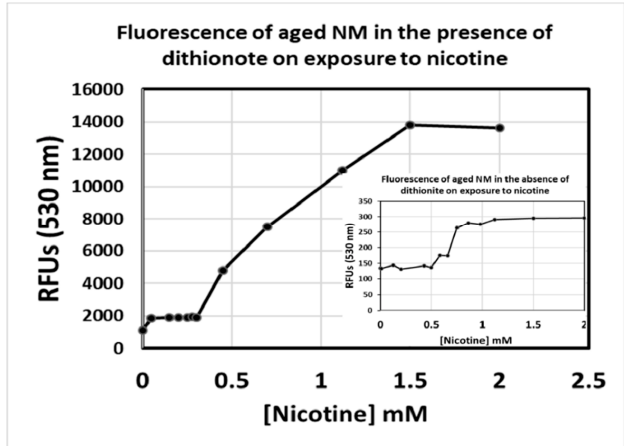
Figure 4. Fluorescence of synthetic neuromelanin upon exposure to nicotine in the absence (inset) and presence of sodium dithionite as a reducing agent. Synthetic NM-Fe 3+ that had been aliquoted into a sealed, 15 mL conical tube and stored in a dark cupboard for over 3 months was tested for signal upon addition of nicotine as per a slight variation on our published procedure (emission monitored at a wavelength of 530 nm; inset). The nicotine still appears to saturate in the 0.65 mM range, but RFU values are some 2-orders of magnitude lower than expected (inset). Upon addition of 1% sodium dithionite, signals matching the rang of RFU values seen when the batch of NM-Fe was first synthesized were instantly restored. Values presented are the average of triplicate measurements.